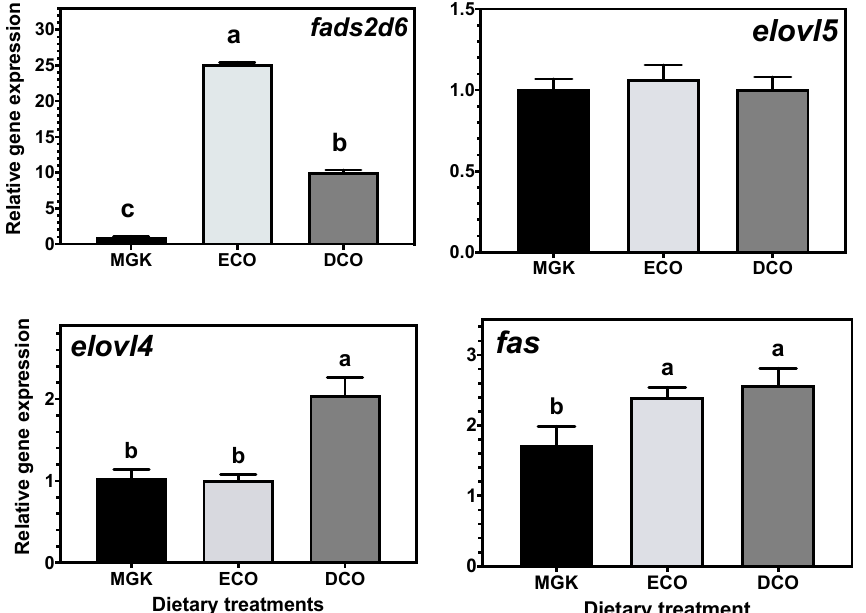
Figure 1. Nutritional regulation of delta-6 fatty acyl desaturase ( fads2d6 ), fatty acyl elongases 4 ( elolv4 ) and 5 ( elovl5 ) and fatty acid synthase ( fas ), gene transcription in liver of Atlantic bluefin tuna ( Thunnus thynnus L.) juveniles fed a reference diet Magokoro ® (MGK) and two test diets containing either EPA (ECO) or EPA + DHA (DCO) oils from transgenic Camelina sativa seeds. Values are normalised expression ratios to MGK reference diet and are means ± SD ( n = 6). Values with different superscript letters are significantly different (one-way ANOVA and Tukey test; p < 0.05). The expression of the fads2d6 gene in the intestine was also upregulated in fish fed both ECO and DCO compared to fish fed MGK although the highest expression was in fish fed DCO (Figure 2). The expression of the elovl5 elongase gene in the intestine was also significantly highest in fish fed DCO, and lowest in fish fed ECO with fish fed MGK